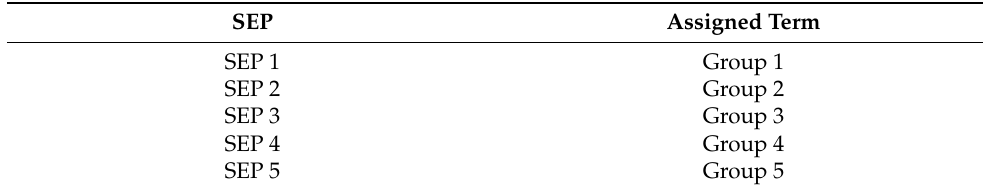
Table 2. SEP term assigned to each group. SEP Assigned Term SEP 1 Group 1